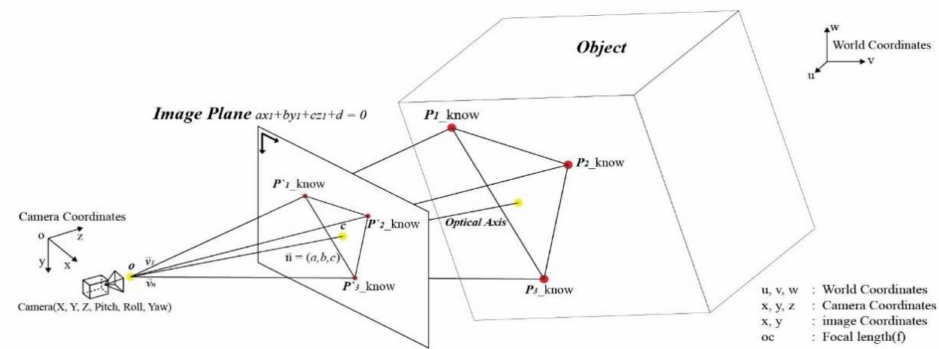
Figure 2. 3D Position Estimation using Perspective-n-Point.